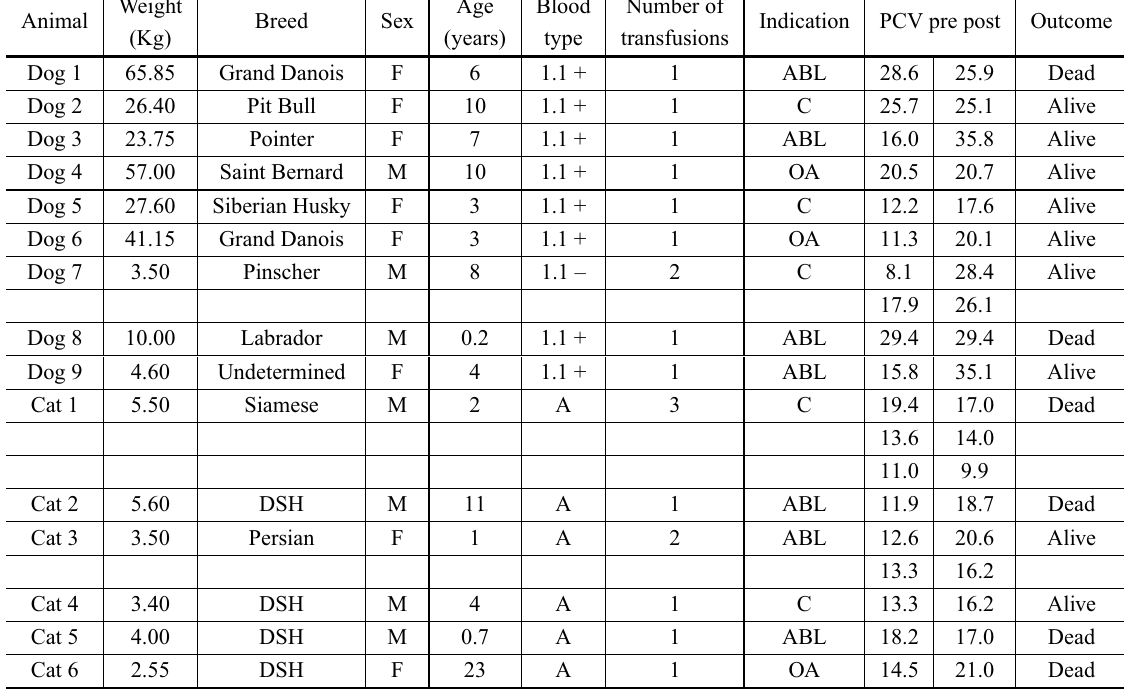
Data from the 15 animals included in this study: weight, breed, sex, age, blood type, number of transfusions, transfusion indication (ABL, acute blood loss; C, coagulopathy; OA, other anaemias), pre- and post- PCV, and